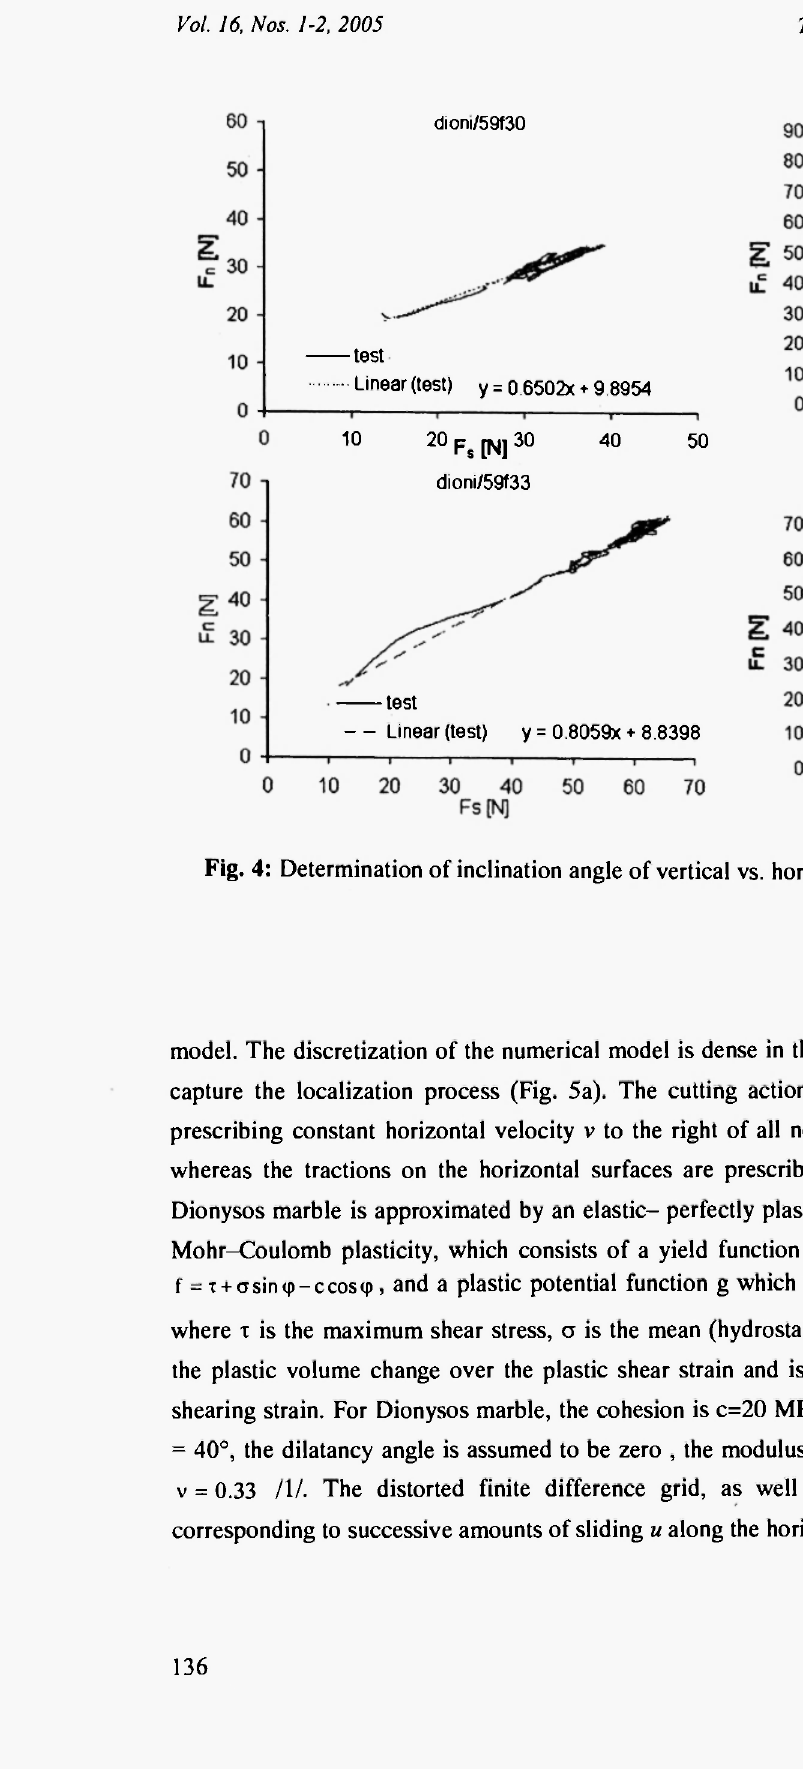
ο test — Unear (test) y = 0.8078x + 8 8175